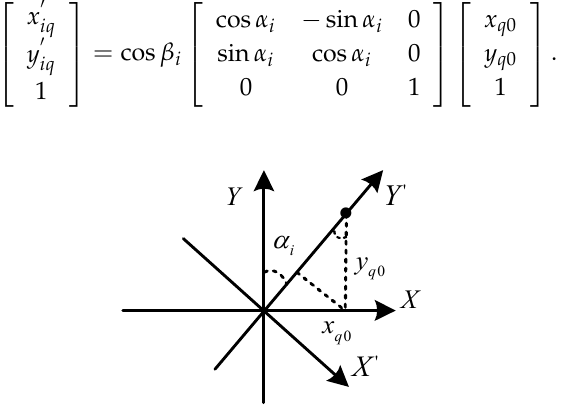
Figure 3. The rotation relationship of